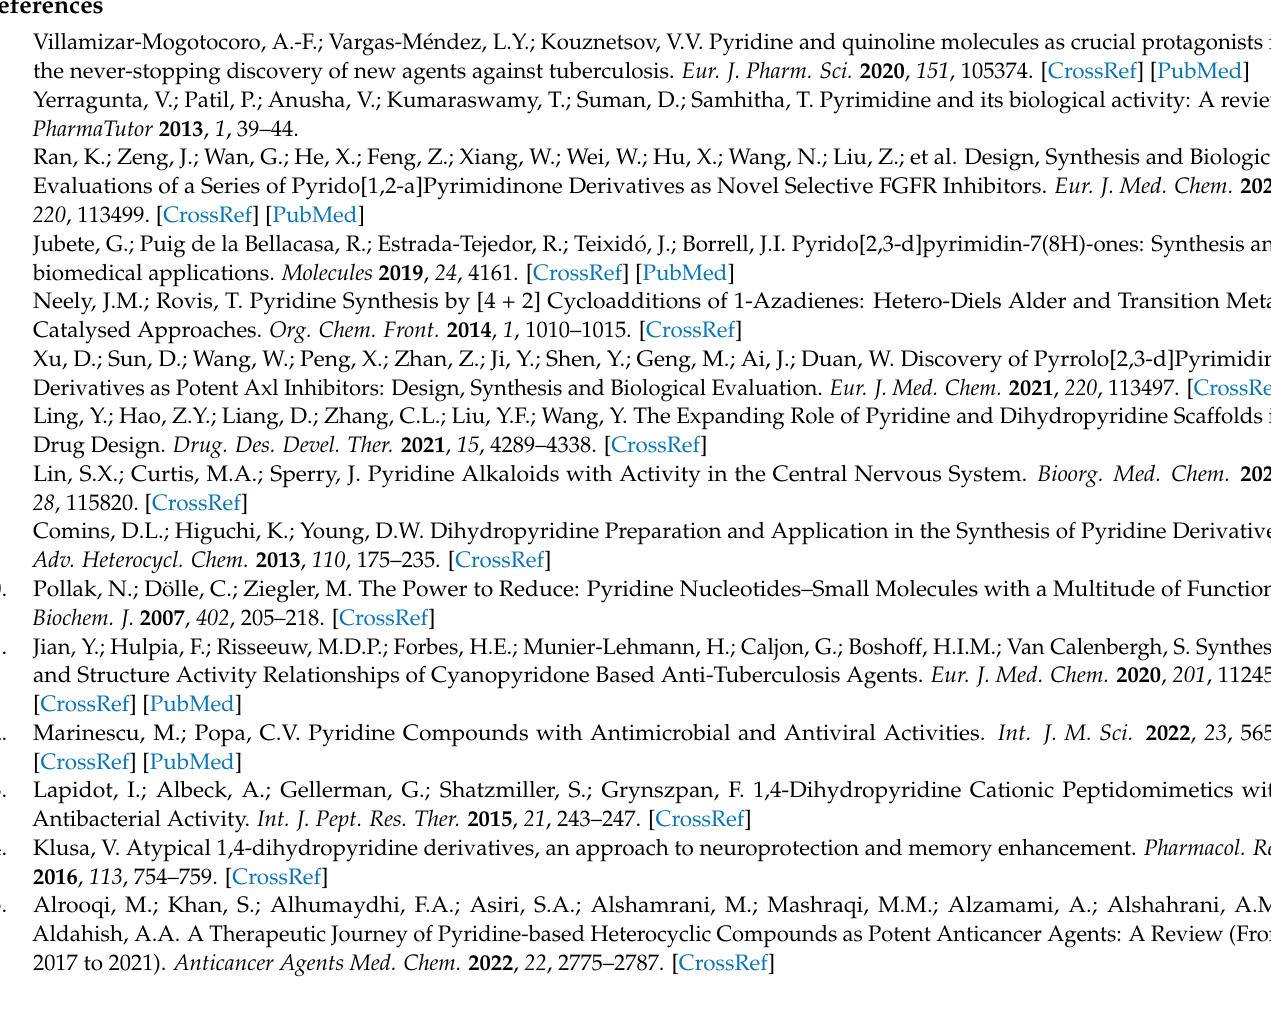
optimized molecular structure for the designed chemical compounds 1a – 1o ; Figure S2. The wire label representation of the optimized molecular structure for the designed chemical compounds 1a – 1o ; Figure S3. LUMO map for the compounds 1a – 1o ; Figure S4. Molecular electrostatic potential map (on the electronic density) for the compounds 1a – 1o ; Figure S5. Local ionization potential map for the compounds 1a – 1o ; Figures S6–S35. Graphic representations of intermolecular interactions between the ligand molecules docked with 2XCS ( S. aureus DNA gyrase B, chain F) using CLC Drug Discovery Workbench Software, Figures S36–S65 Intermolecular interactions between the ligand molecules docked with 4DUH ( E. coli DNA gyrase B, chain A) using CLC Drug Discovery Workbench